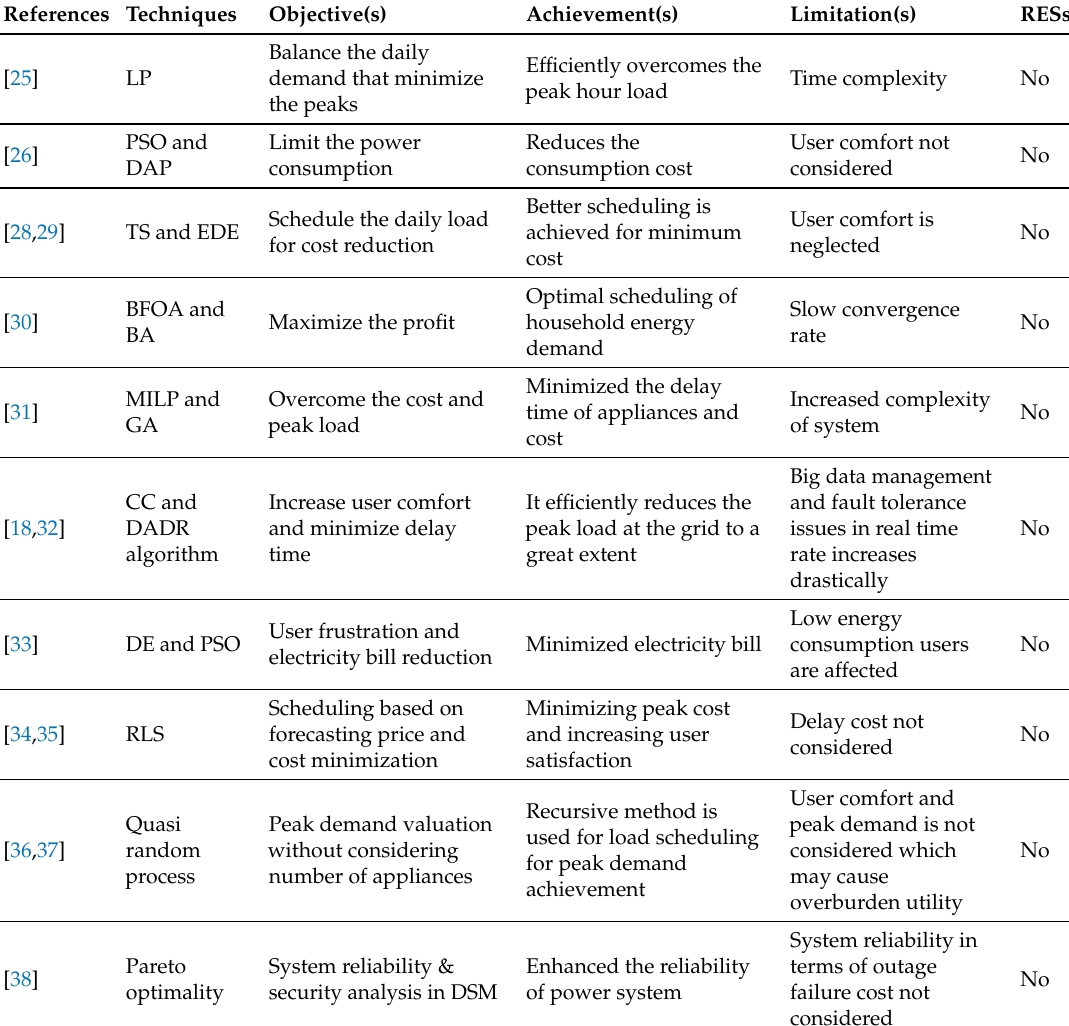
Table 1. Comparison of proposed work against various related